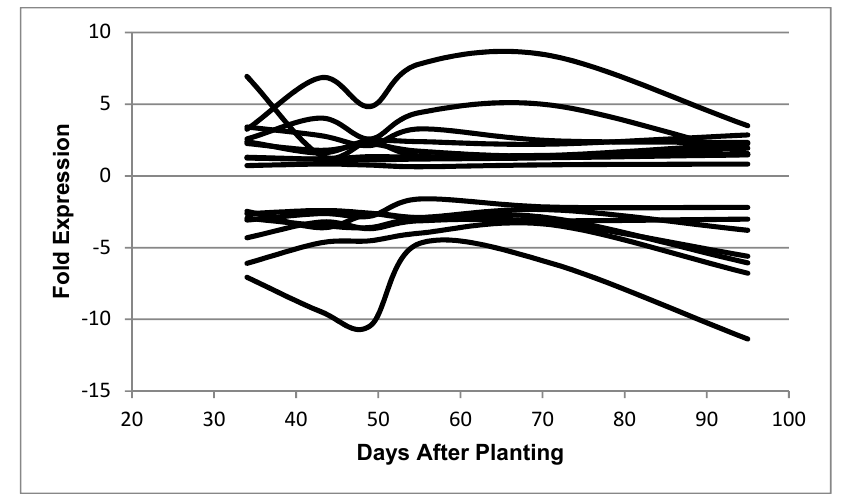
Figure 4. Expression of B . diazoefficiens bacteroid genes related to transcription as a function of days after planting. Fold expression of the transcription-related genes at 95 days after planting: RNA polymerase sigma-54 subunit (3.50), putative RNA polymerase sigma factor protein (2.86), RNA polymerase sigma-54 subunit (2.33), sigma32-like factor (2.25), RNA polymerase sigma-E factor (1.93), sigma-54 modulation protein (1.55), ECF sigma factor (1.49), ECF family sigma factor (1.47), RNA polymerase (0.82), cold-shock dead-box protein A ( − 2.20), DNA-directed RNA polymerase beta chain ( − 3.01), DNA-directed RNA polymerase beta chain ( − 3.79), RNA polymerase omega subunit ( − 5.60), transcription anti-termination protein ( − 6.06), DNA-directed RNA polymerase alpha subunit ( − 6.78), and ATP-dependent RNA helicase ( −